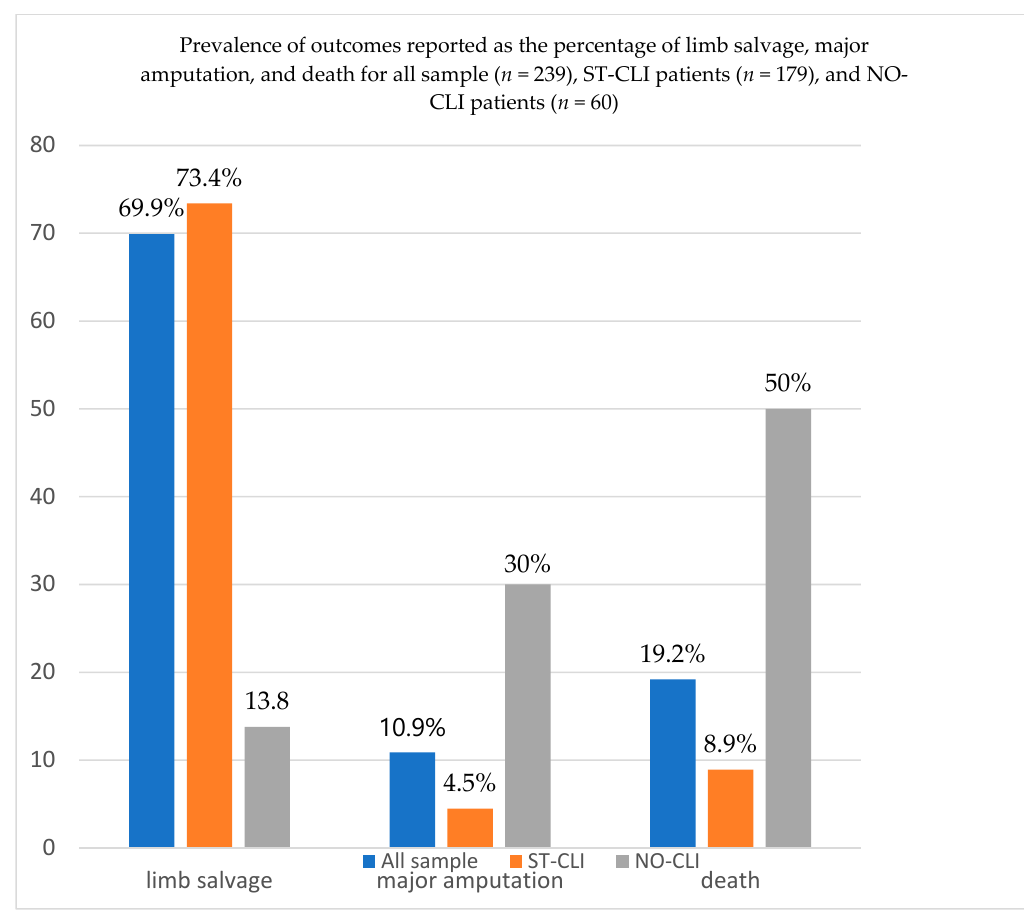
Figure 1. The 1 year outcomes for the whole population, ST-CLI patients, and NO-CLI patients were, respectively, as follows: limb salvage (69.9%, 73.4%, and 13.8%), major amputation (10.9%, 4.5%, and 30%), and death (19.2%, 8.9%, and 50%). ST-CLI: successfully treated critical limb ischemia; NO-CLI: no-option critical limb ischemia.